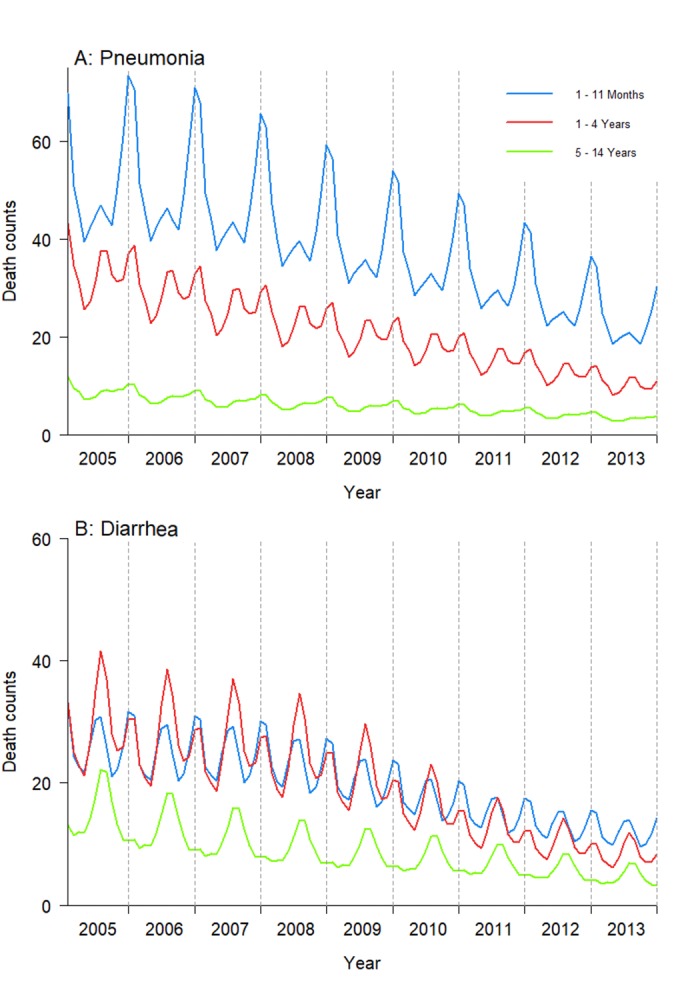
Time series model for (A) pneumonia and (B) diarrhea, by age subset.Diarrhea cases shown here are only those that did not exhibit fever and bloody stool. Data was modeled using a generalized additive model and Poisson regression, using monthly count of deaths from the Million Death Study. Each dashed vertical line designates December of each year.10.7554/eLife.46202.015Figure 4—figure supplement 1—source data 1.Predicted values for pneumonia and diarrhea mortality time series models by child age subset; 2005–2013.